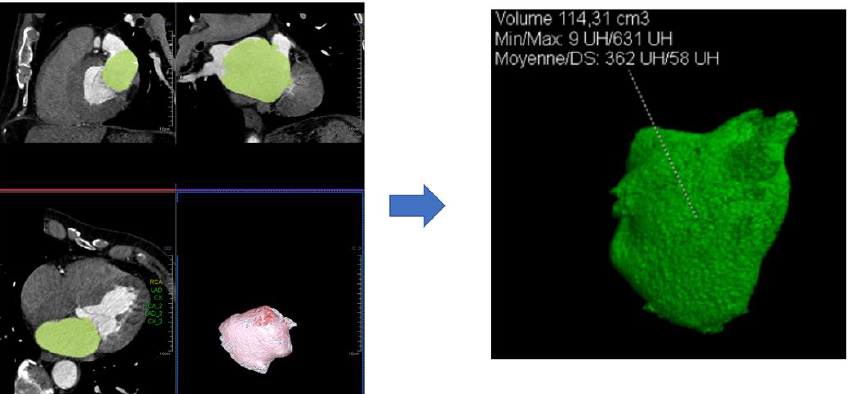
Figure 2. Left Atrial volume assessment using ECG-gated cardiac multidetector CT.